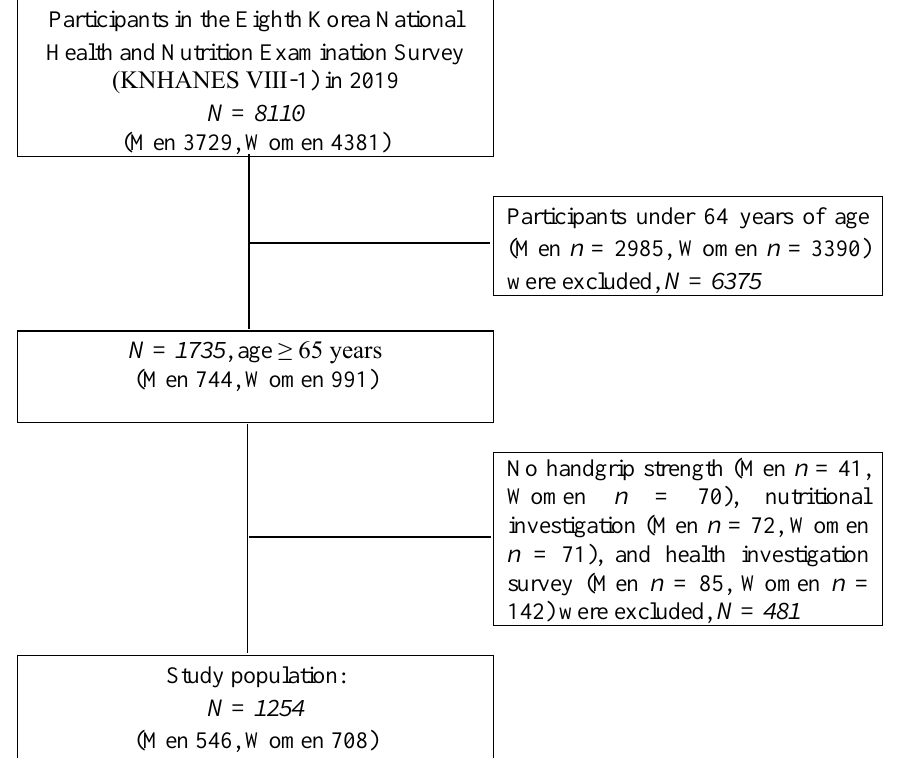
Figure 1. Flowchart of the study population from the Korean National Health and Nutrition Examination Survey (2019), showing the inclusion and exclusion criteria.